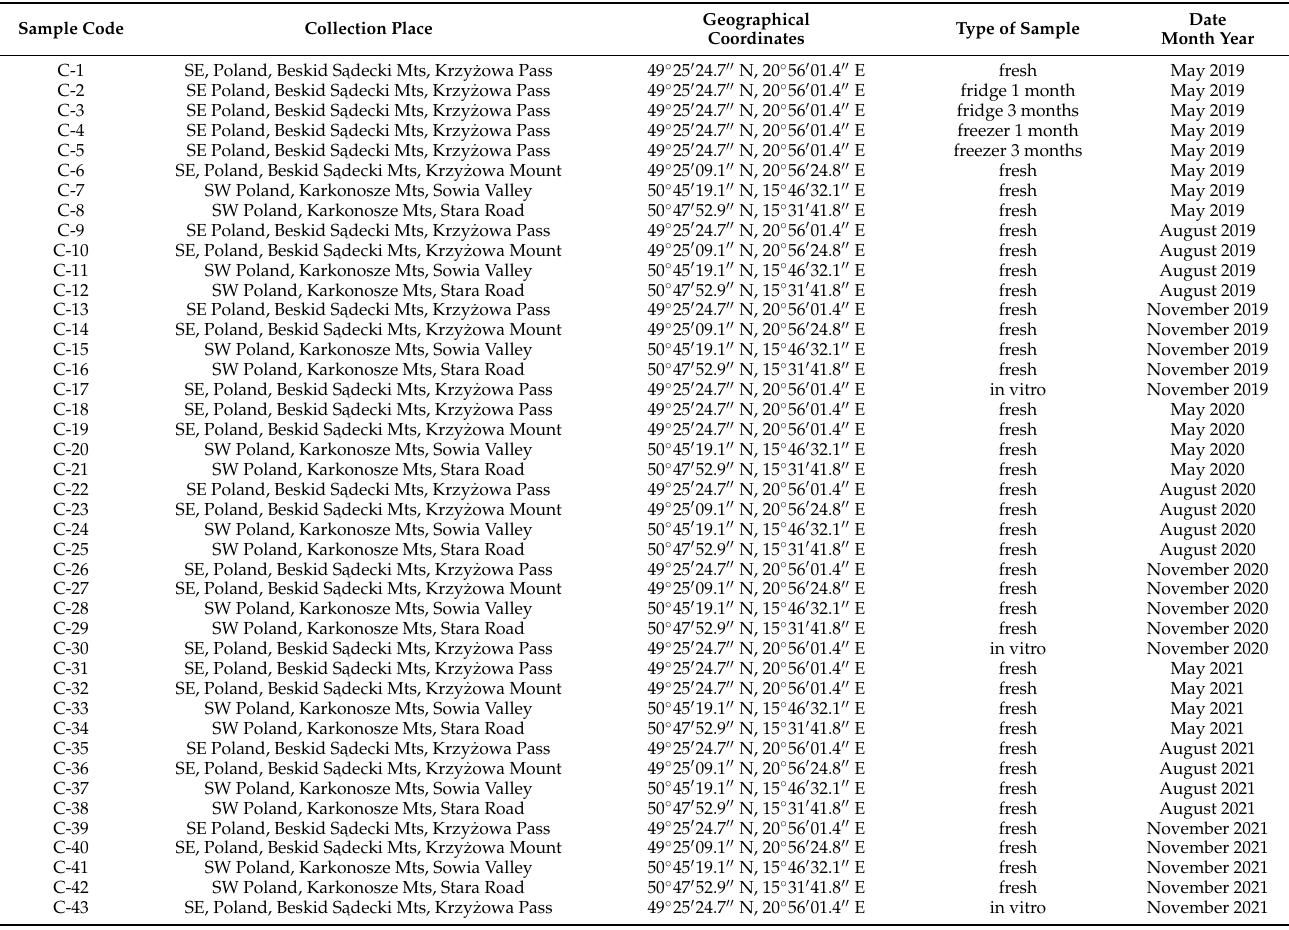
Table 1. The Calypogeia azurea sampling data used for